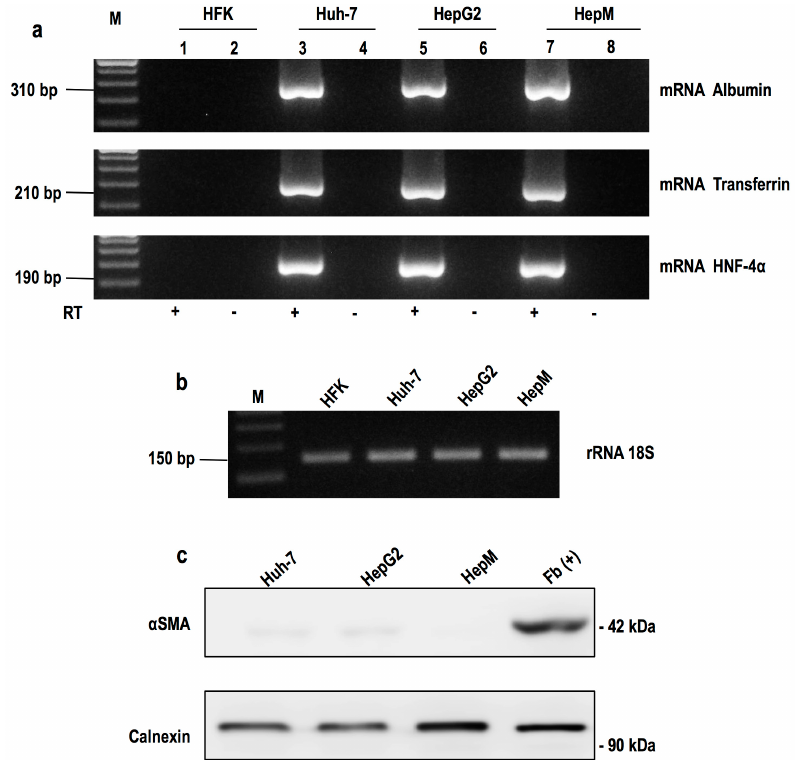
Figure 1. Expression of hepatic markers by RT-PCR and Western blot: ( a ) Markers of hepatic mRNAs were amplified. Electrophoresis agarose seen in the amplified fragments of 310, 210 and 190 bp, corresponding to albumin, transferrin and HNF-4 α , respectively. The fragment was generated from the cDNA obtained from total RNA Huh-7, HepG2 and HEPM cells. Huh-7 and HepG2 cells were used as positive control. HFK cells were used as negative control. Reverse transcriptase in the absence of product is not detected (lanes 2, 4, 6, 8). M corresponds to the marking of 100 bp molecular size; ( b ) Constitutively expressed gene 18S rRNA was used as an internal control; ( c ) Expression of the protein α SMA. By Western blot, the protein expression of α SMA was determined in the hepatic (Huh-7, HepG2 and HepM) and fibroblast cells (Fb (+)). Constitutively expressed calnexin was used as an internal control.